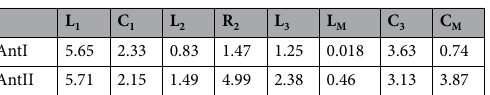
Table 1. Matching passives element values for AntI and AntII.